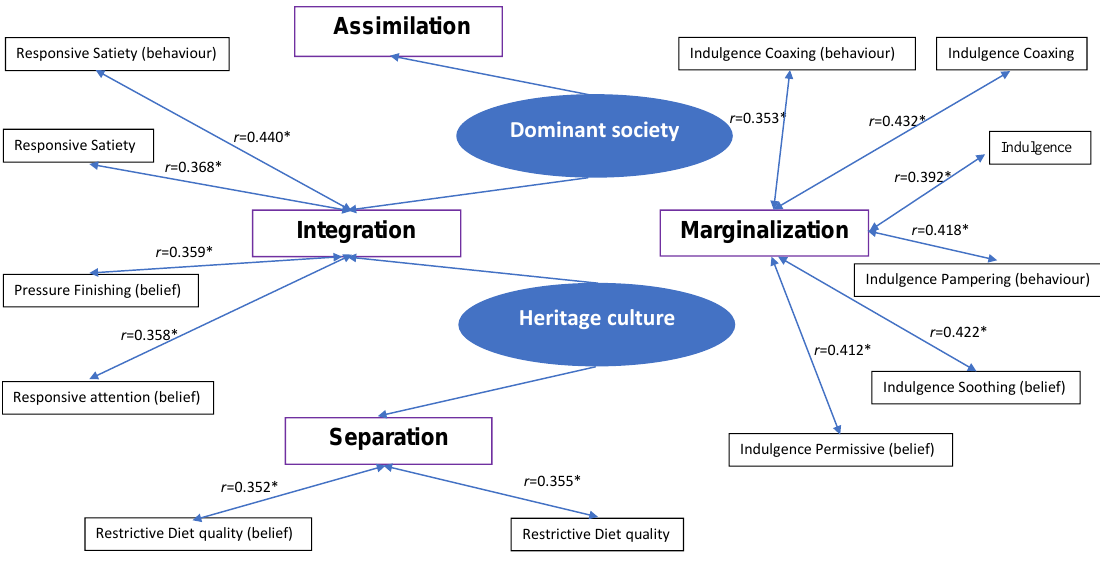
Figure 1. The association between acculturation and CIYCFP. * Correlation is significant at the 0.05 level Figure 1. Pearson Correlation coefficients analysis results of the association of acculturation and complementary infant and young child feeding practices. * Correlation is significant at the 0.05 level (2-tailed).